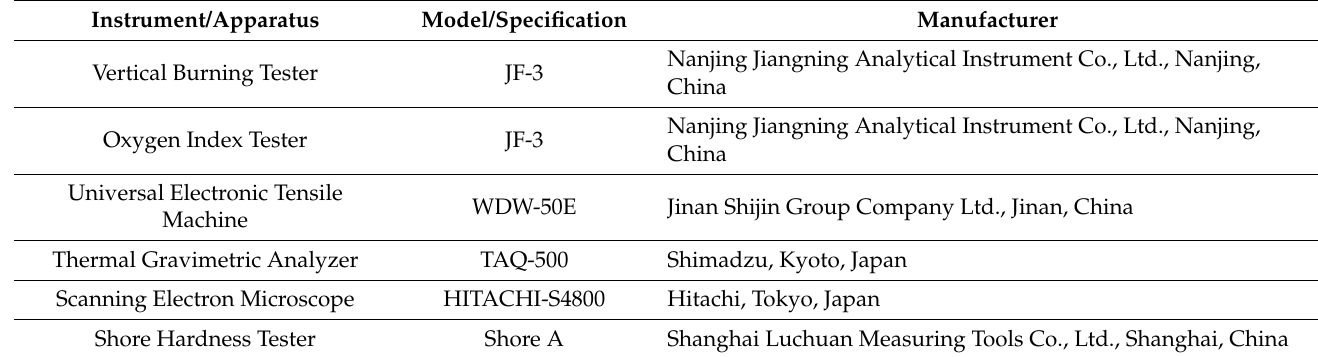
Table 2. Experimental instruments and